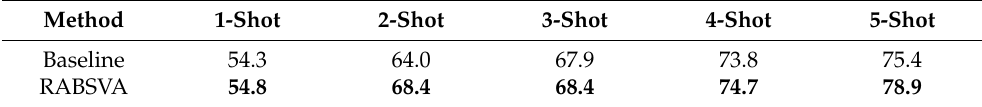
Table 2. The top-1 performance from 1 to shot to 5-shot using 3D ResNet-50 as backbone on HMDB-49.